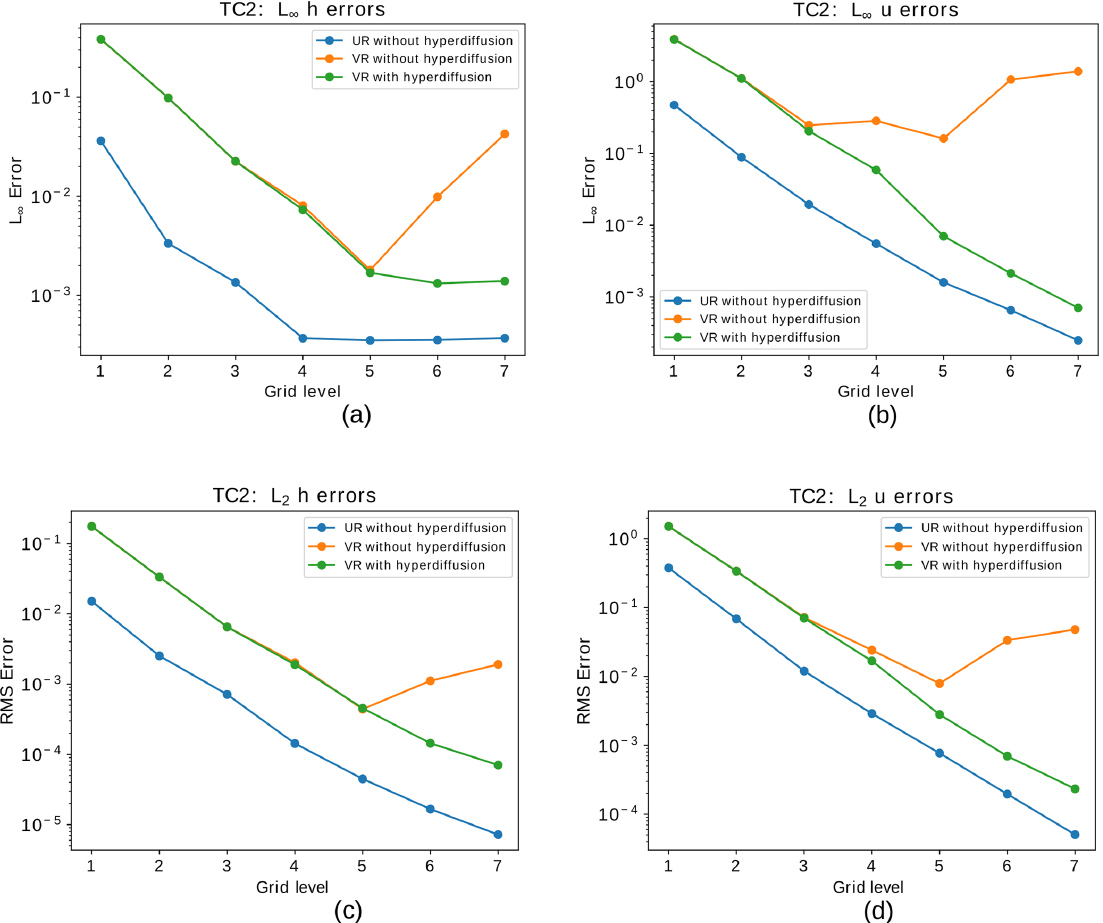
Figure 10. Steady geostrophic flow test case: convergence of relative error in the L ∞ norm for the height field (a) and the normal component of the velocity field (b) with respect to errors at day 30. Panels (c) and (d) show the same as (a) and (b) , respectively, but for the L 2 norm. The blue lines indicate the errors for the uniform SCVT grids, while the orange lines show the error for the variable-resolution grids with refinement based on topography, and the green lines show the error for the same variable-resolution grids but adding numerical fourth-order hyperdiffusion based on the alignment index in the shallow-water